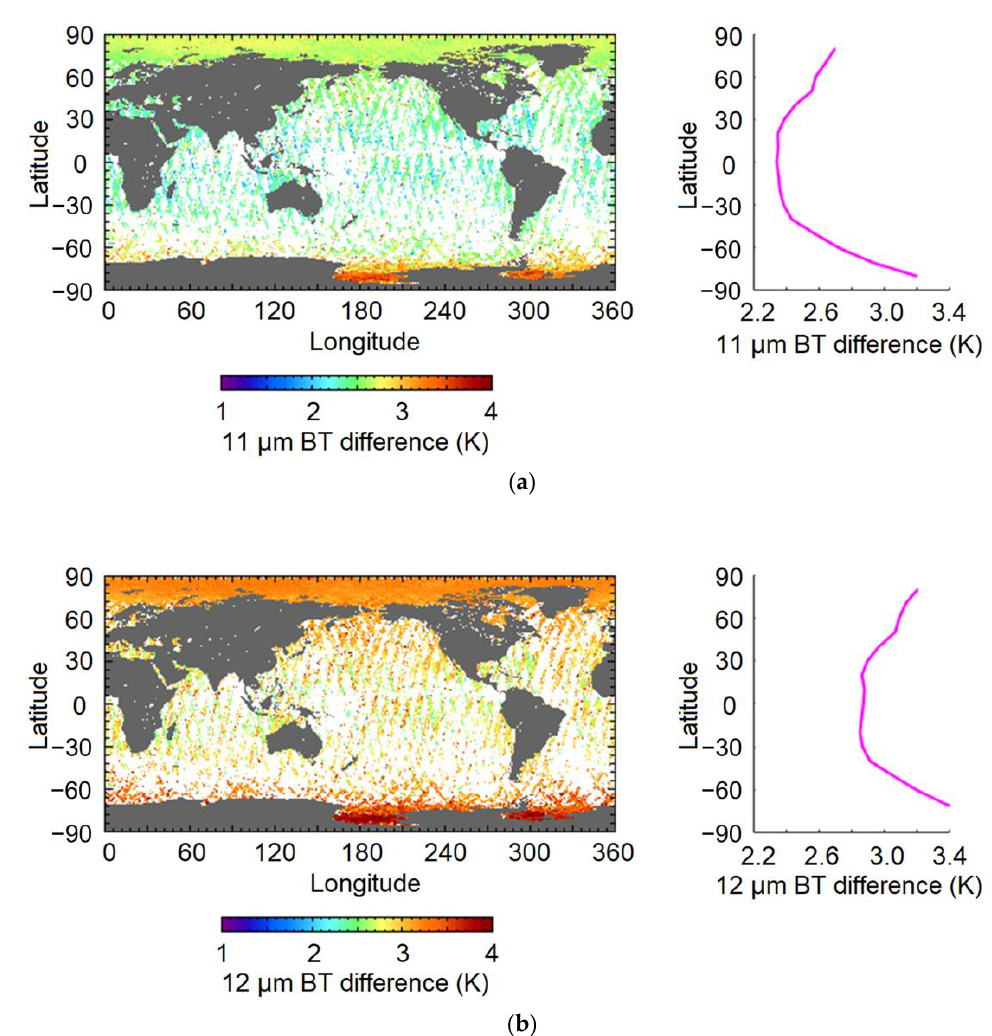
Figure 6. The geophysical distribution of the COCTS minus IASI BT differences for ( a ) 11 and ( b ) 12 µm channel. The color in the left panels indicates the COCTS minus IASI BT differences of the collocations. The purple lines in the right panels are the variations in the mean values of BT differences in every 10° latitude bin.